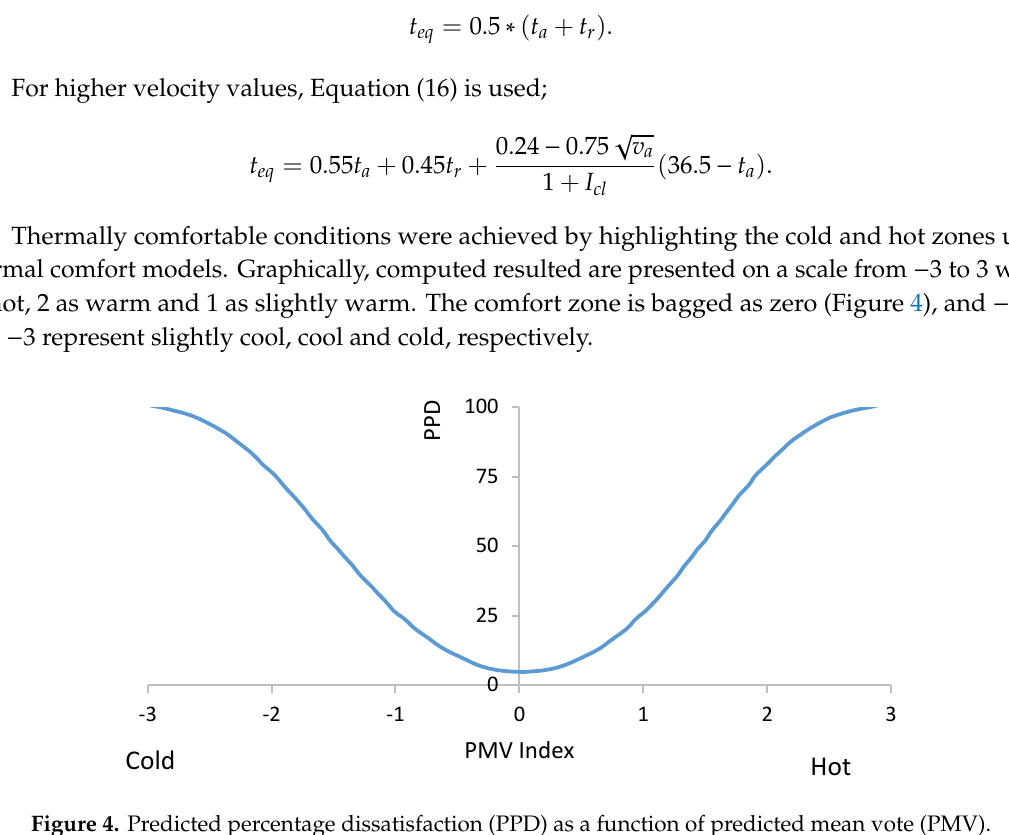
Figure 5. Results validation for the cooling down process.